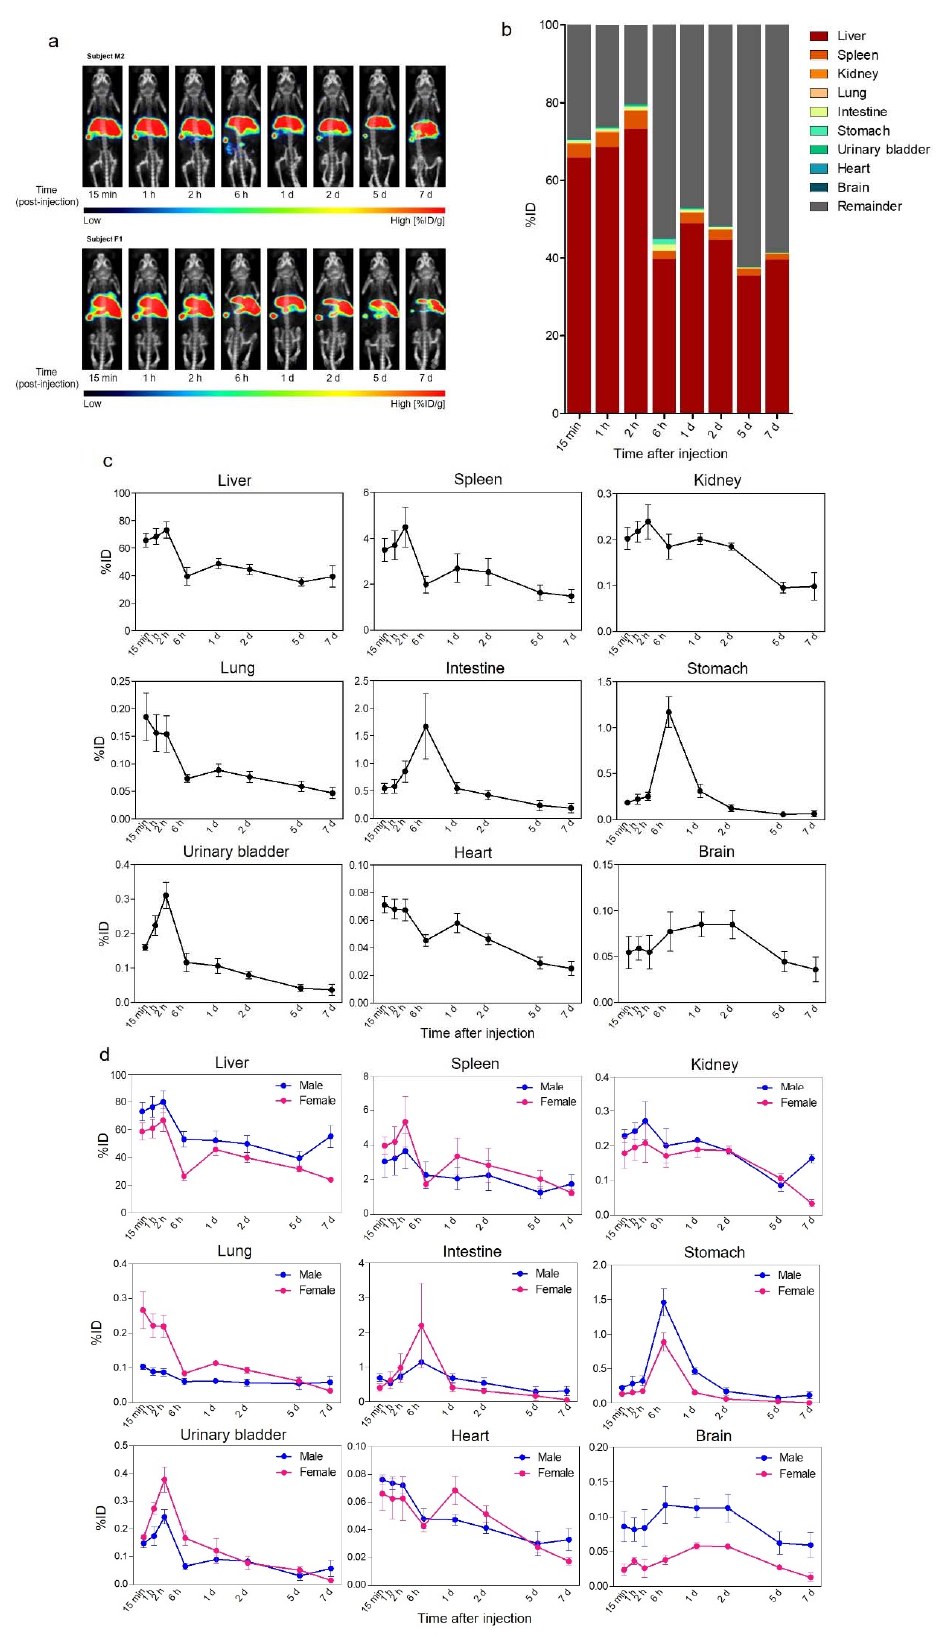
Figure 2. Biodistribution of 89 Zr-labeled GMP-grade exosomes in mice imaged using PET/CT. ( a ) Biodistribution of i.v.-administered 89 Zr-Exo in mice was evaluated using PET/CT imaging,